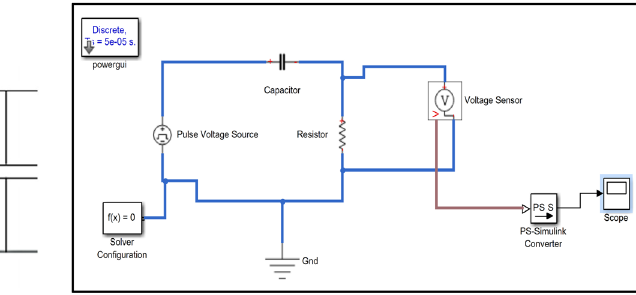
Figure 12: Capacitor model of cavity in insulation.